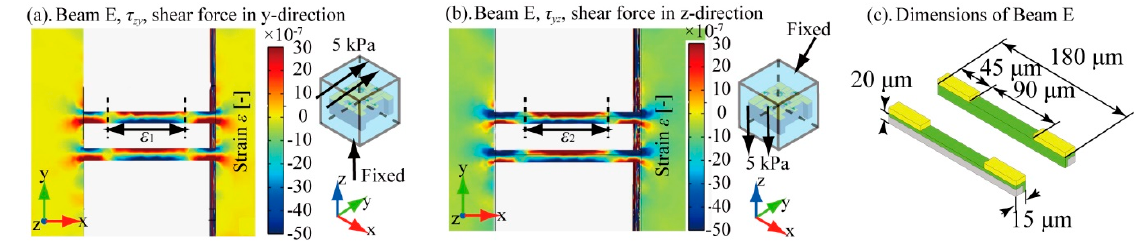
Figure 5. FEM simulation of shear stresses τ zy and τ yz . ( a ) strain distribution around Beam E caused by τ zy , ( b ) strain distri- bution around Beam E caused by τ yz , and ( c ) sensor dimensions to detect shear stresses.